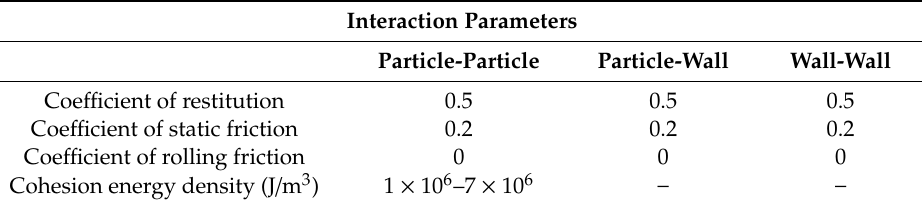
Table 2. Summary of interaction parameters used in DEM